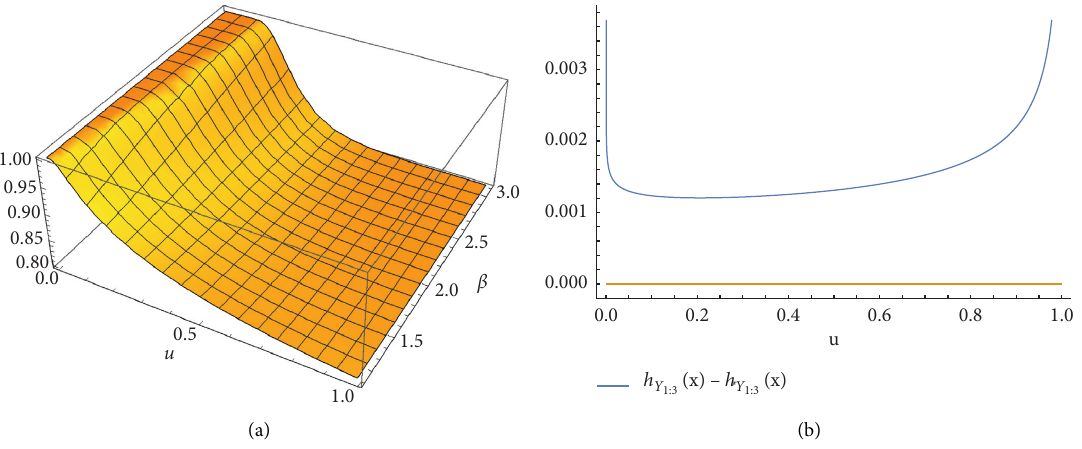
Figure 4: (a) Plot of the ratio function F h ( x ) − h ( x ) , for all x � − ln u , u ∈ ( 0 , 1 ] Y 1 : 3 Y ∗ 1 : 3